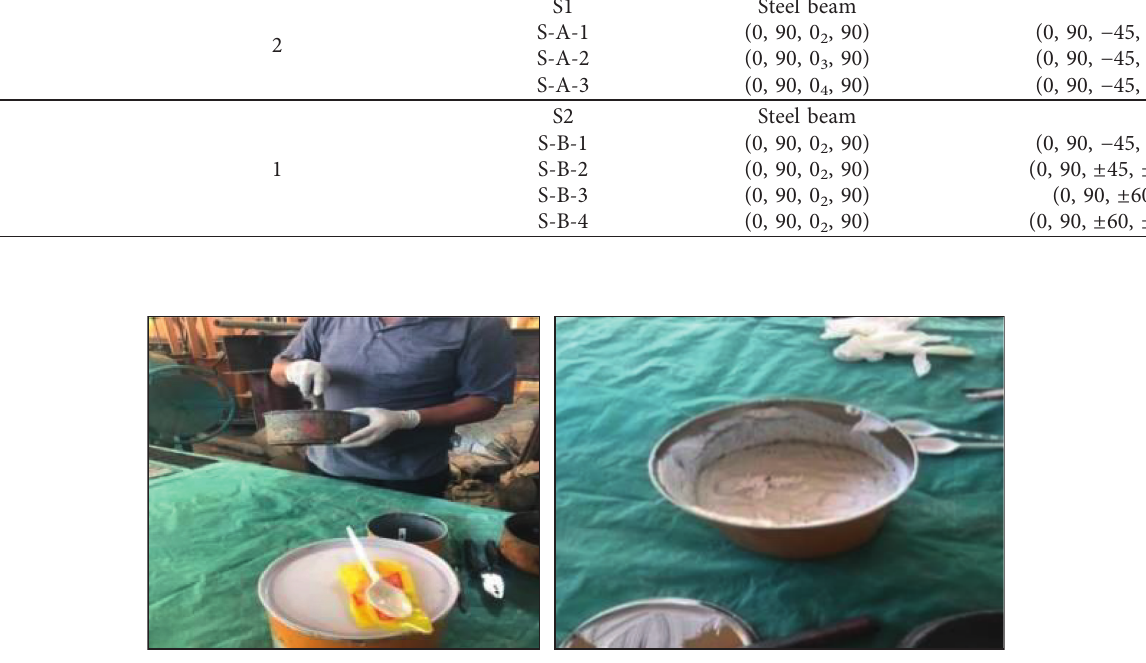
Figure 2: Preparation of the matrix.